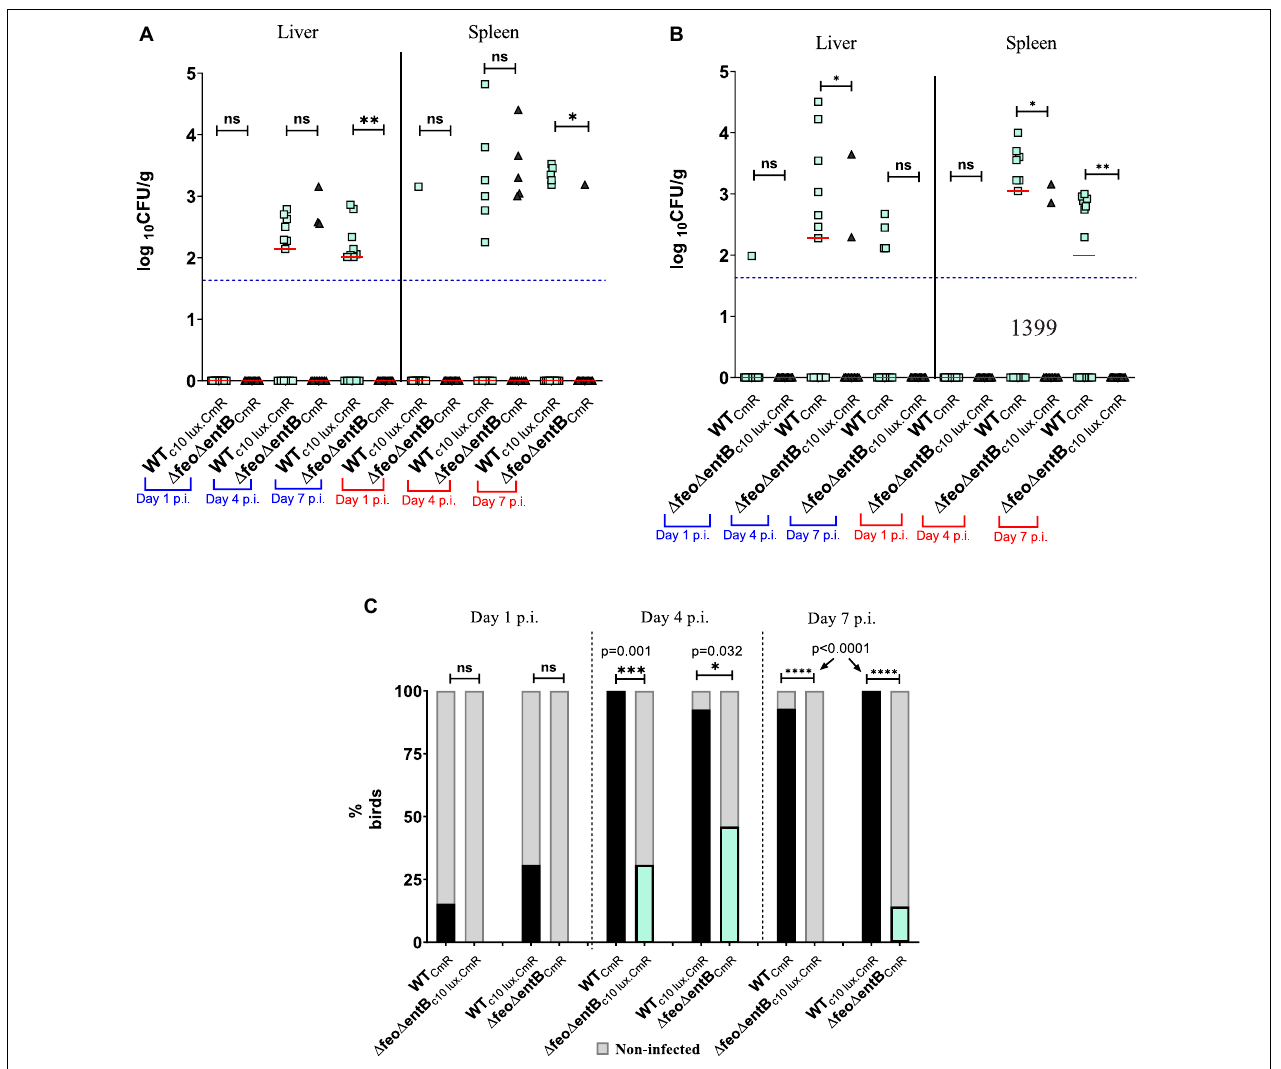
FIGURE 5 | (A,B) Wildtype or (cid:49) feo (cid:49) entB burden in liver and spleen by direct plating. Each symbol represents a colony count of a particular bird (13–14 birds/time point), and each bird has a matching pair of wildtype/mutant colony counts due to the co-infection. Median value of the data is given by the horizontal bar. The detection limit of the XLD agar plate is around 50 CFU/g as indicated in horizontal dotted line. Differences between the median of the data set was accounted. In (A) ∗ , p = 0.0407 (spleen), ∗∗ p = 0.0019 (liver); (B) ∗ p = 0.0492 (liver), ∗ p = 0.0159 (spleen), ∗∗ , p = 0.0058 (spleen). (C) Infectivity of wildtype or (cid:49) feo (cid:49) entB obtained by liver and spleen enrichments. Dark column represents % birds for infected by the strain which are recovered by liver/spleen enrichments. Non-infected% of birds presented by shaded gray. Fisher’s exact test used for statistical analysis. ns: not significant. ∗∗∗ p = 0.001, ∗ p = 0.032, ∗∗∗∗ p = <0.0001.